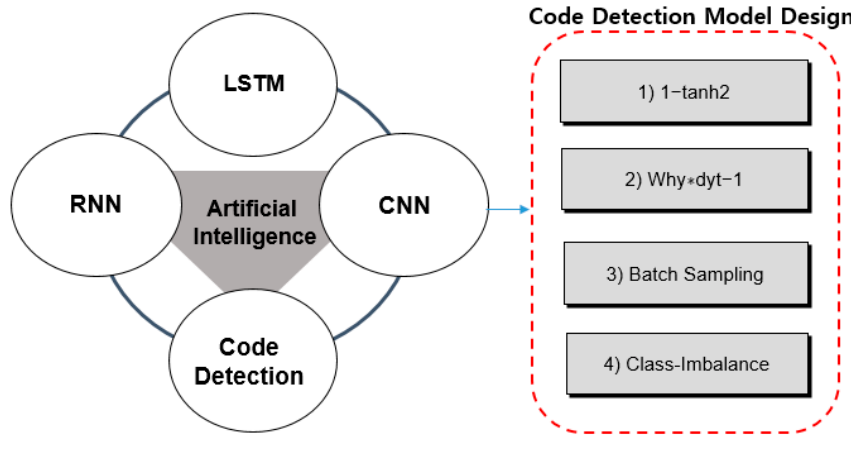
Figure 7. Code Detection Model Design.